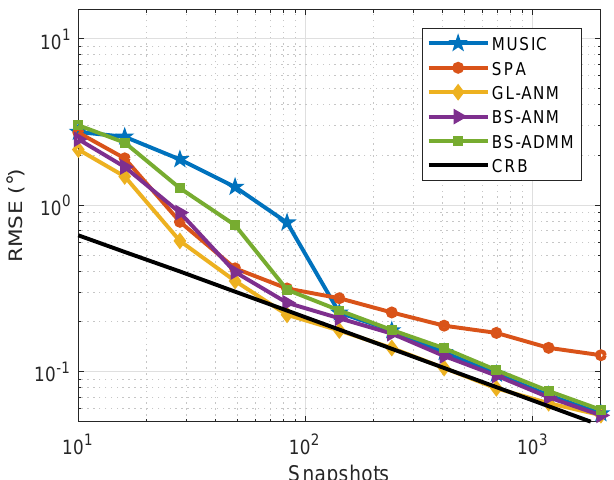
Figure 5. RMSE comparison for uncorrelated sources at θ = 5 ◦ and θ = − 10 ◦ , SNR = − 10 dB when the number of snapshots varies from 10 to 2000.